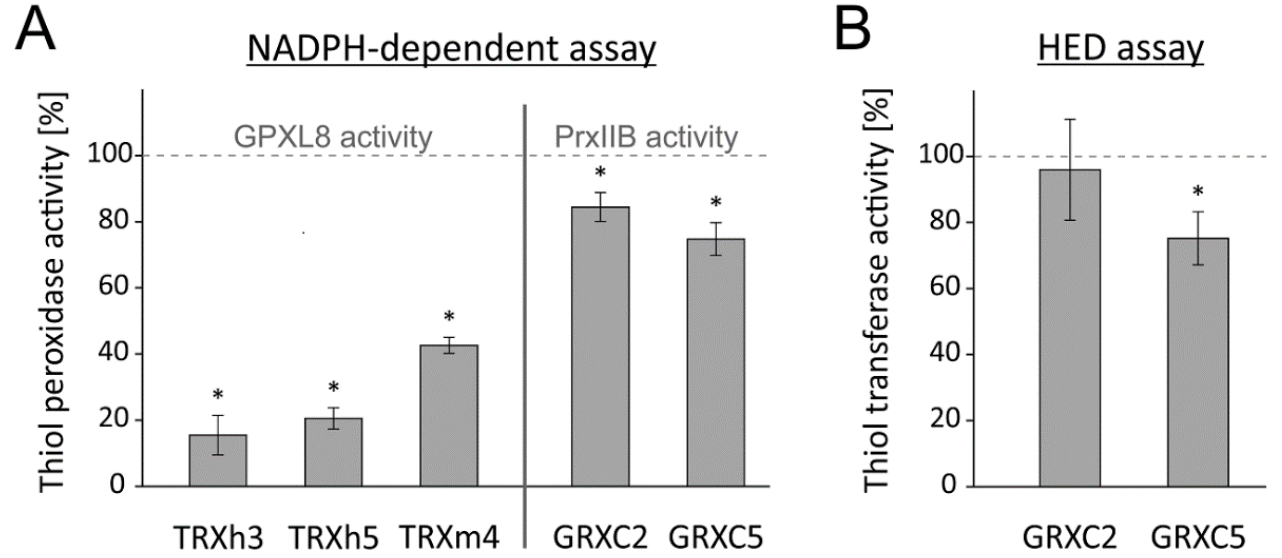
Figure 10. OPDA effect on thiol peroxidase-dependent H 2 O 2 detoxification using the reconstituted system and on the thiol reduction activity of GRXs. ( A ) In total, 20 µM reduced TRX-h3, TRX-h5, TRX-m4, GRXC2 and GRXC5 were incubated with 150 µM OPDA for 1 h. The GPXL8-dependent activity was measured using TRX-h3 (0.25 µM), TRX-h5 (0.25 µM) or TRX-m4 (5 µM) and the PRXIIB-dependent activity using GRXC2 (0.25 µM) and GRXC5 (0.25 µM), after 1 h preincubation as described before. Data are means ± SD of n ≥ 6. Significance of difference was determined using t -test ( p < 0.05) and is marked with *. ( B ) HED assay to determine GRX-dependent reduction activity. In total, 20 µM reduced GRXC2 and GRXC5 were incubated with 150 µM OPDA for 1 h. The activity in the HED assay was measured after 1 h preincubation. The assay contained 200 µM NADPH, 2 mM GSH, 0.7 mM HED, 1 µM GR and 0.1 µM GRXC2. Data are means ± SD of n ≥ 12. * marks significant differences to corresponding measurements without OPDA as determined by t -test ( p < 0.001).